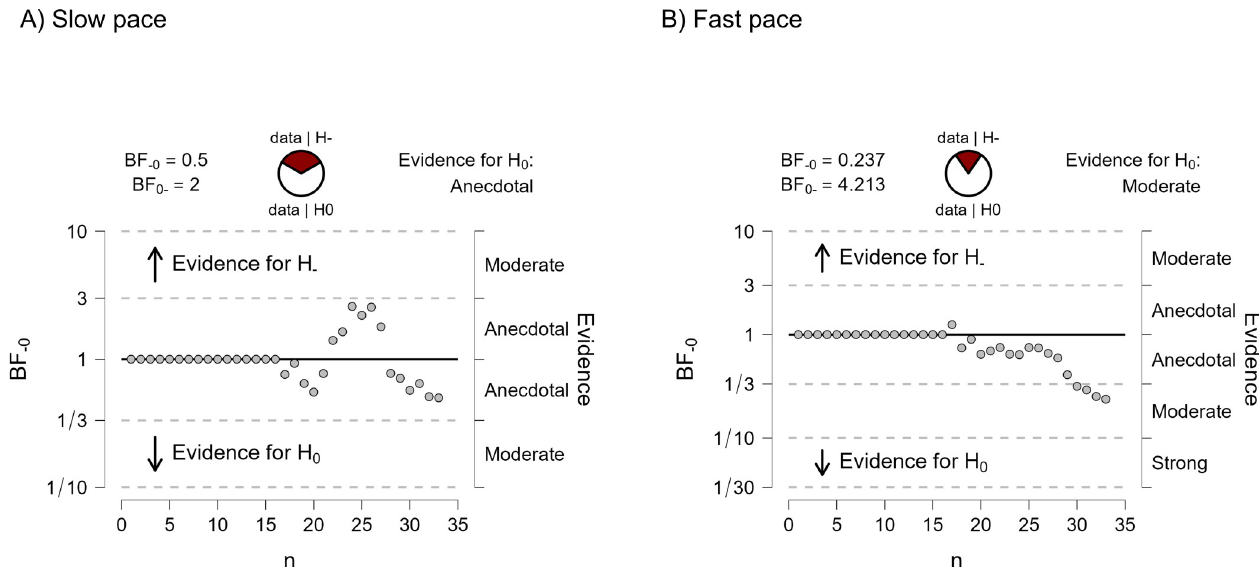
Fig 3. Sequential Bayesian analysis of the mean spans in Experiment 1. The panels reproduce the output from Jasp (Jasp Team, 2022) The x-axis of each plot represents the participant number and the y-axis represents the magnitude of the BF. Each point in the plot represents a change in the BF caused by the addition of a participant in the analysis. The horizontally aligned dots until n = 15, on the left side of each plot, correspond to data in the ADHD group. https://doi.org/10.1371/journal.pone.0282896.g003 Both ADHD and controls were included in this analysis. The model that best fitted the data was the one including the main effects of pace and age (BF = 1.603 x 10 8 , error = 1.162). The 10 second-best model was the one including the main effects of pace, age, and inattention, with a Bayes factor very close to the best model (BF = 1.6 x 10 8 , error = 1.43). We found decisive evi- 10 = 4.39 x 10 7 ) and moderate evidence for the dence for the inclusion of the pace effect (BF incl inclusion of the age effect (BF = 9.13) in the model. Regarding the T -scores of inattention, incl